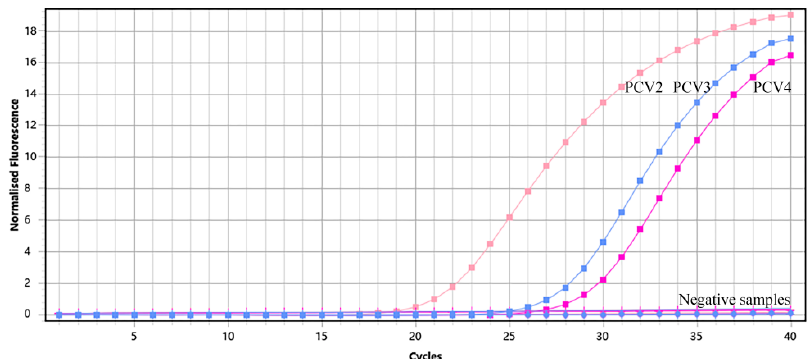
Figure 2. Amplified curves of specificity analysis of multiplex TaqMan